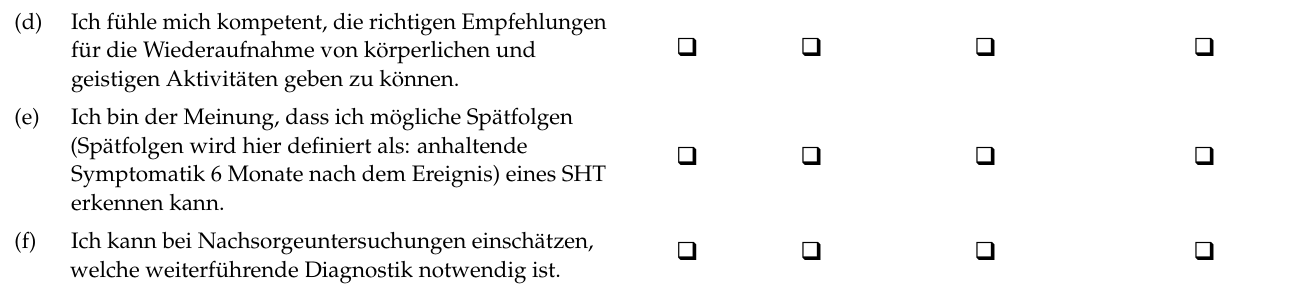
Schwindel Rededrang Rededrang Gleichgewichtsstörungen Gleichgewichtsstörungen 16. Welche Symptome können auf Spätfolgen 16. Welche Symptome können auf Spätfolgen (Spätfolgen wird hier definiert als: anhaltende (Spätfolgen wird hier definiert als: anhaltende Symptomatik 6 Monate nach dem Ereignis) eines SHT Symptomatik 6 Monate nach dem Ereignis) eines SHT hindeuten? hindeuten? Konzentrationsstörungen Konzentrationsstörungen Gedächtnisstörungen Gedächtnisstörungen Reizbarkeit/Nervosität Reizbarkeit/Nervosität